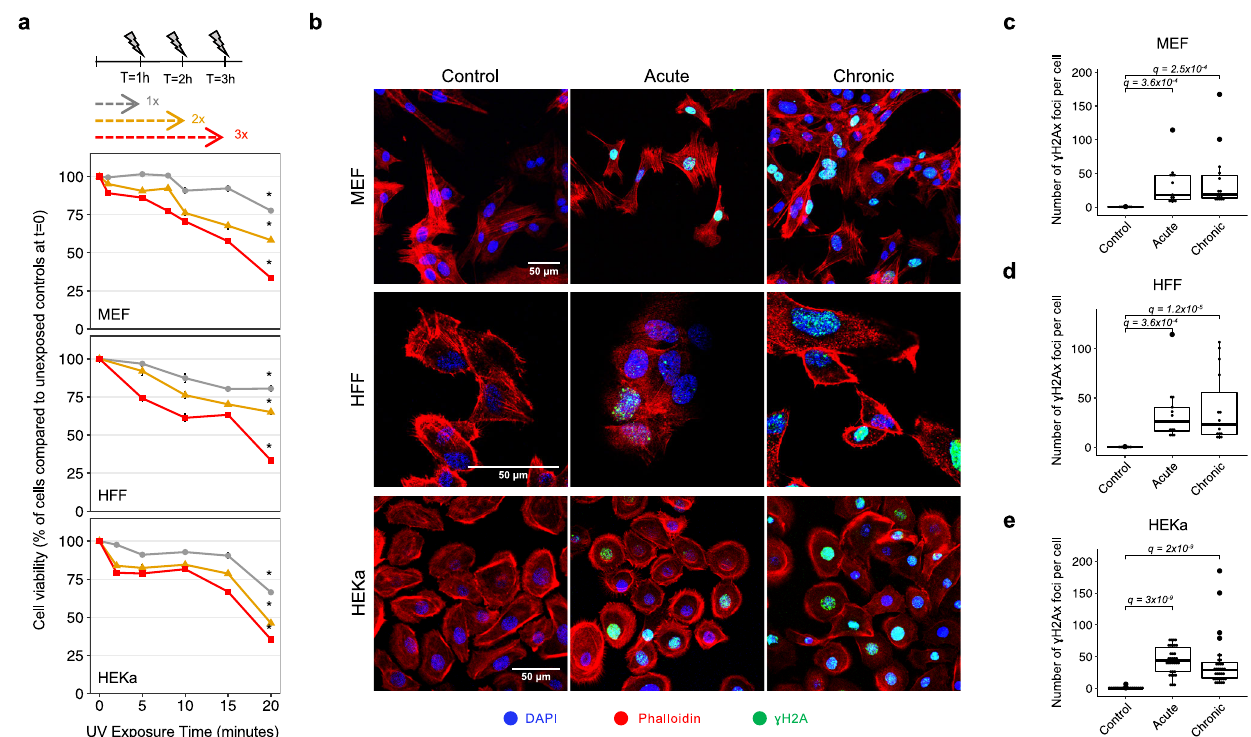
Fig.2|Cytotoxicityandgenotoxicityinmammaliancellsafterirradiationwith a UV-nail dryer. a Cytotoxicity assessment following exposure of primary MEFs (toppanel),HFFs(middlepanel),andHEKa(bottompanel)toUVradiationemitted from a UV-nail polish dryer for different timepoints, ranging from 0 to